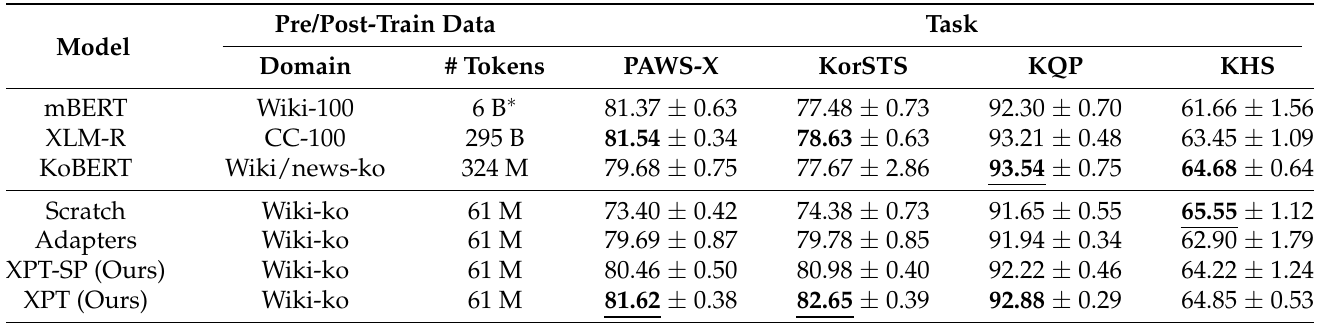
Table 3. Downstream evaluation results. Best values in each block are highlighted in bold, and the overall bests are highlighted with underline. * Estimated value by extrapolation.